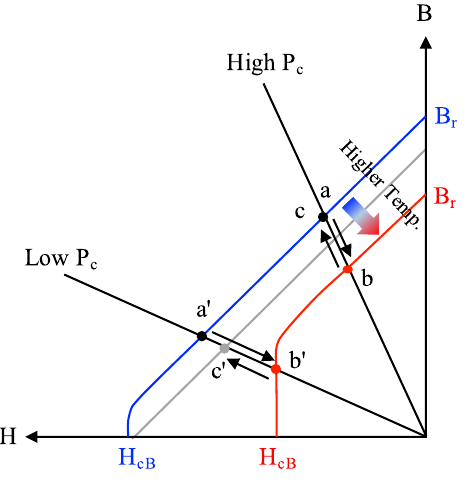
FIG. 2. Movement of operating point on B-H curve under heat cycle. While the operating point moves a – b – c for high P c , it moves a ’ – b ’ – c ’ for low P c , and an irreversible demagnetization occurs.